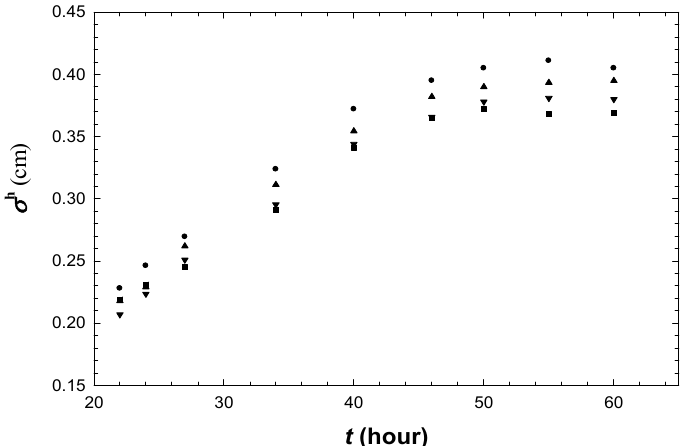
Figure 10. Variation of the roughness, σ h with t for different lengths of the boundary.